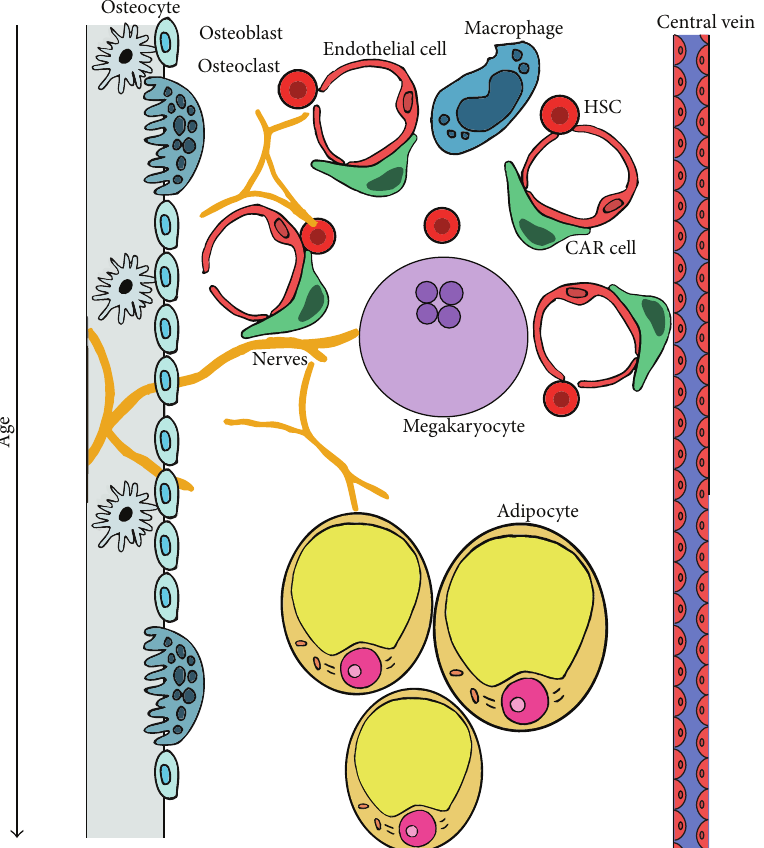
Figure 3: Cellular interactions within the adult bone marrow niche. The bone marrow niche is home to a variety of cell types that promote or inhibit the maintenance of HSCs and haematopoietic progenitors. The endosteal niche and perivascular niche can be clearly discerned. Adipocytes fill the marrow with age, inhibiting blood cell